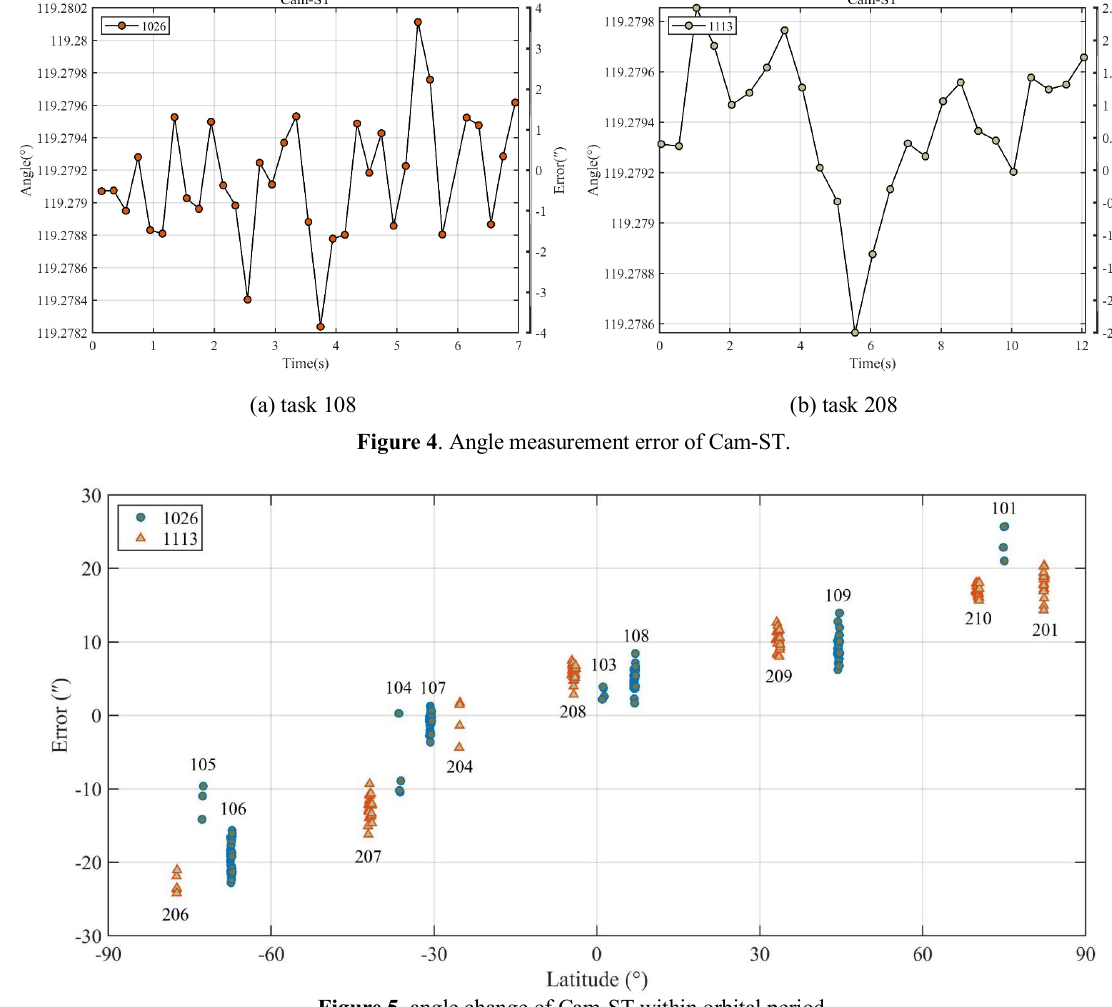
Figure 5 . angle change of Cam-ST within orbital